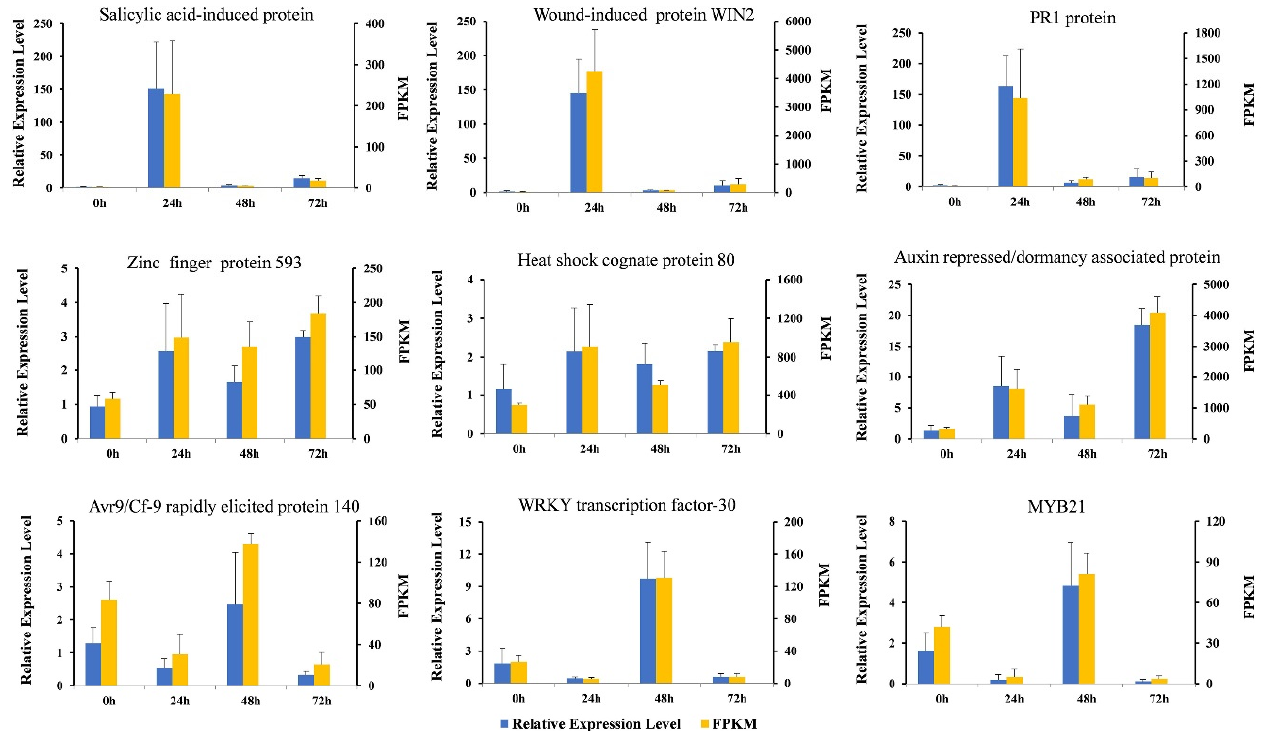
Figure 7. Validation of expression patterns of selected genes by qRT-PCR. The ordinate on the left represents the relative expression level of the genes, the ordinate on the right represents the FPKM of the genes, and the abscissa represents the infection time point. The blue and yellow columns are the relative expression level and FPKM of the genes, respectively. The bars represent the standard errors of three biological replicates.